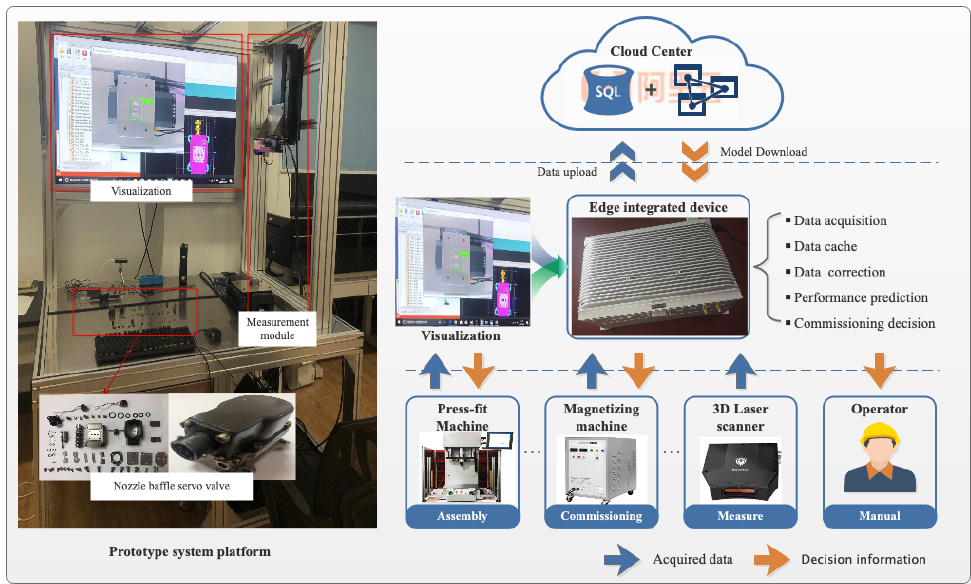
Figure 7. Prototype system platform